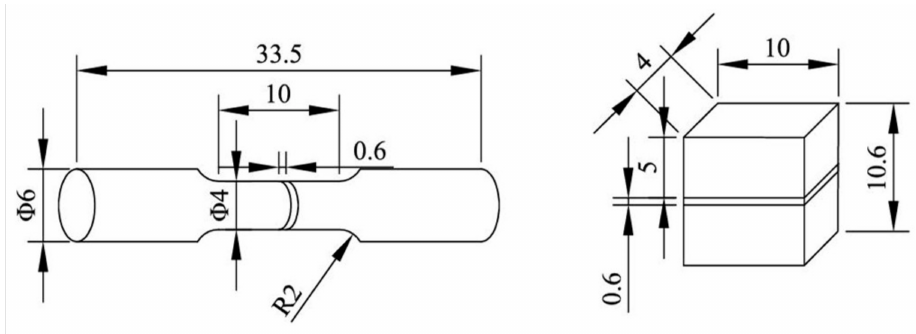
Figure 3. Sizes of the small cuboids and the tensile